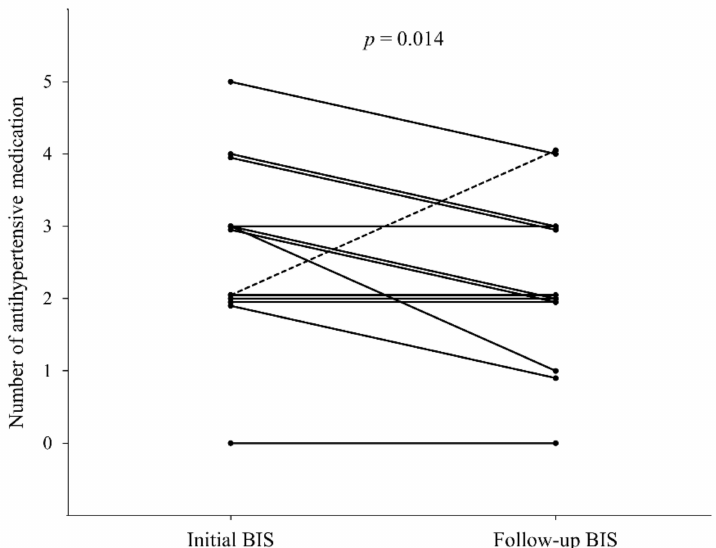
Figure 2. Changes in number of antihypertensive drugs after dialysis prescription in patients with fluid overload ( n = 13). The dashed line represents a patient on intravenous nicardipine during the initial bioimpedance spectroscopy (BIS) measurement. Statistical analysis was performed using Wilcoxon signed rank sum test in 12 patients except the above